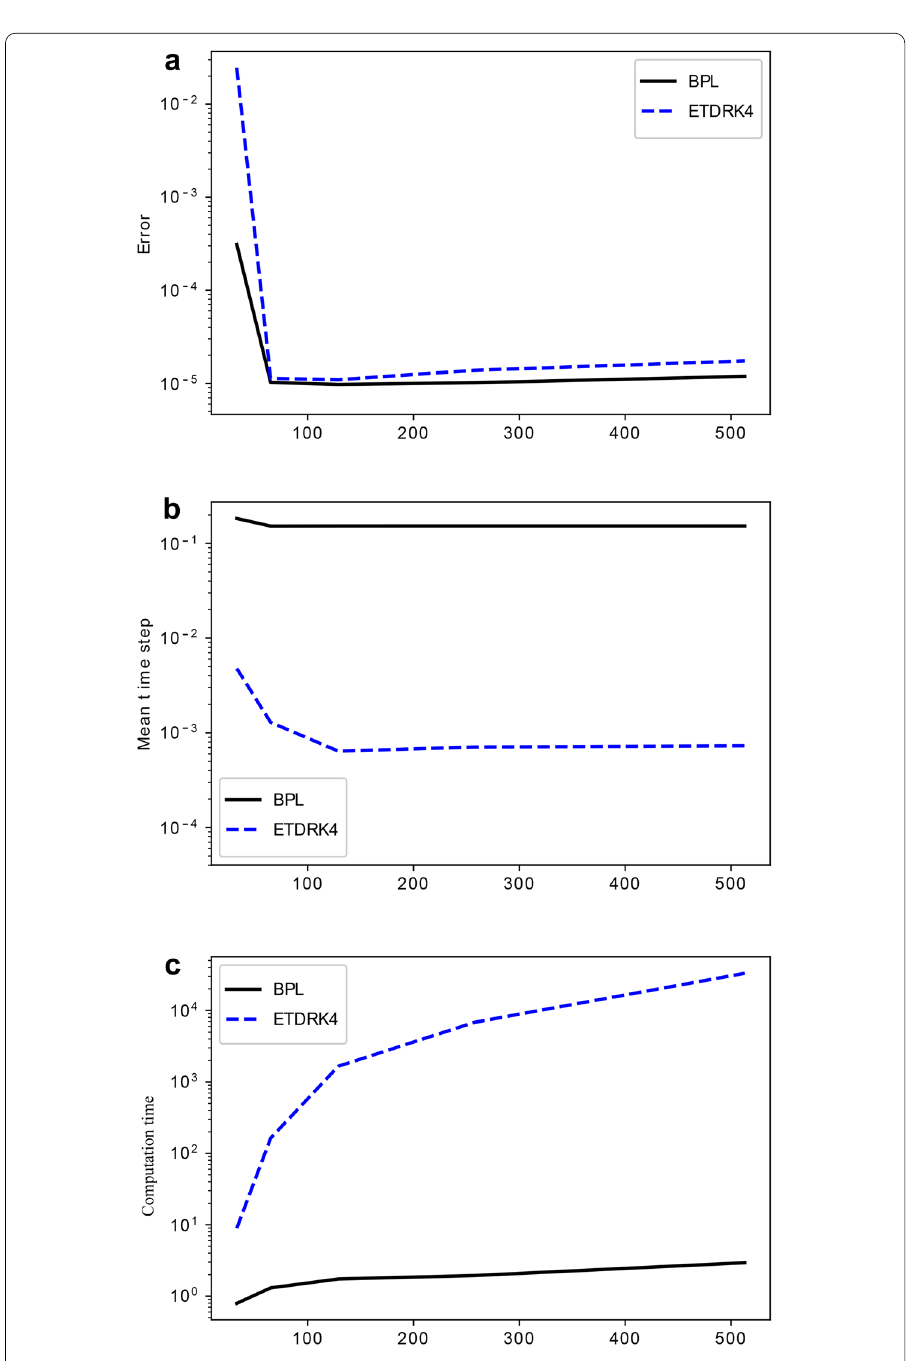
Fig. 17 Evolution of the error ( a ), the time step ( b ) and the computation time ( c ) with the size d of the problem